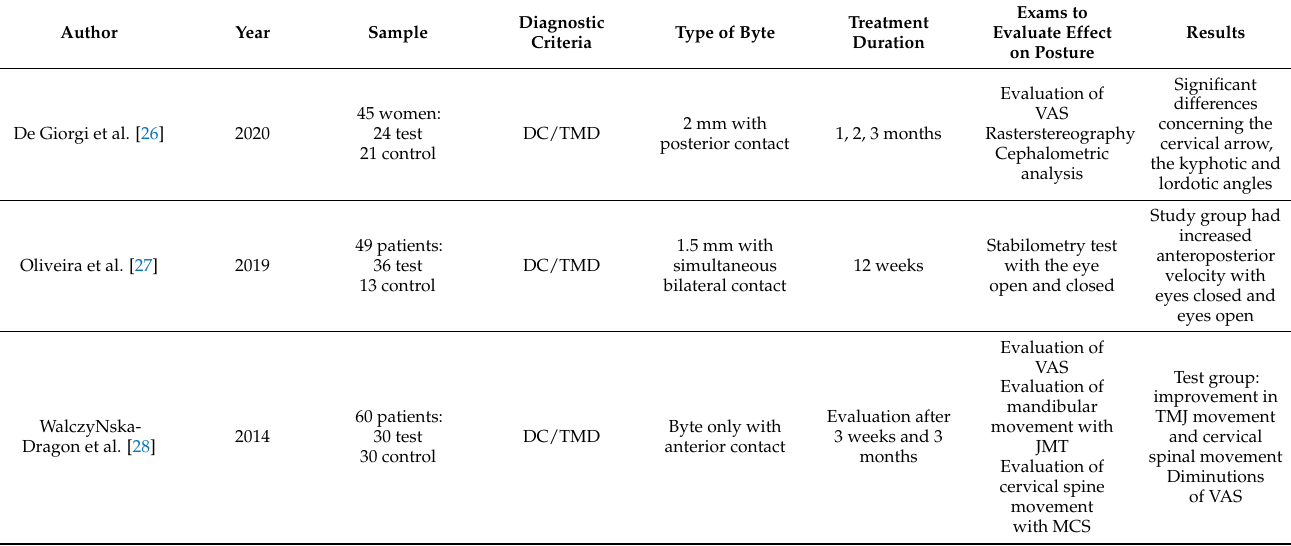
Table 2. Principal elements of the studies which formed part of the present systematic analysis.